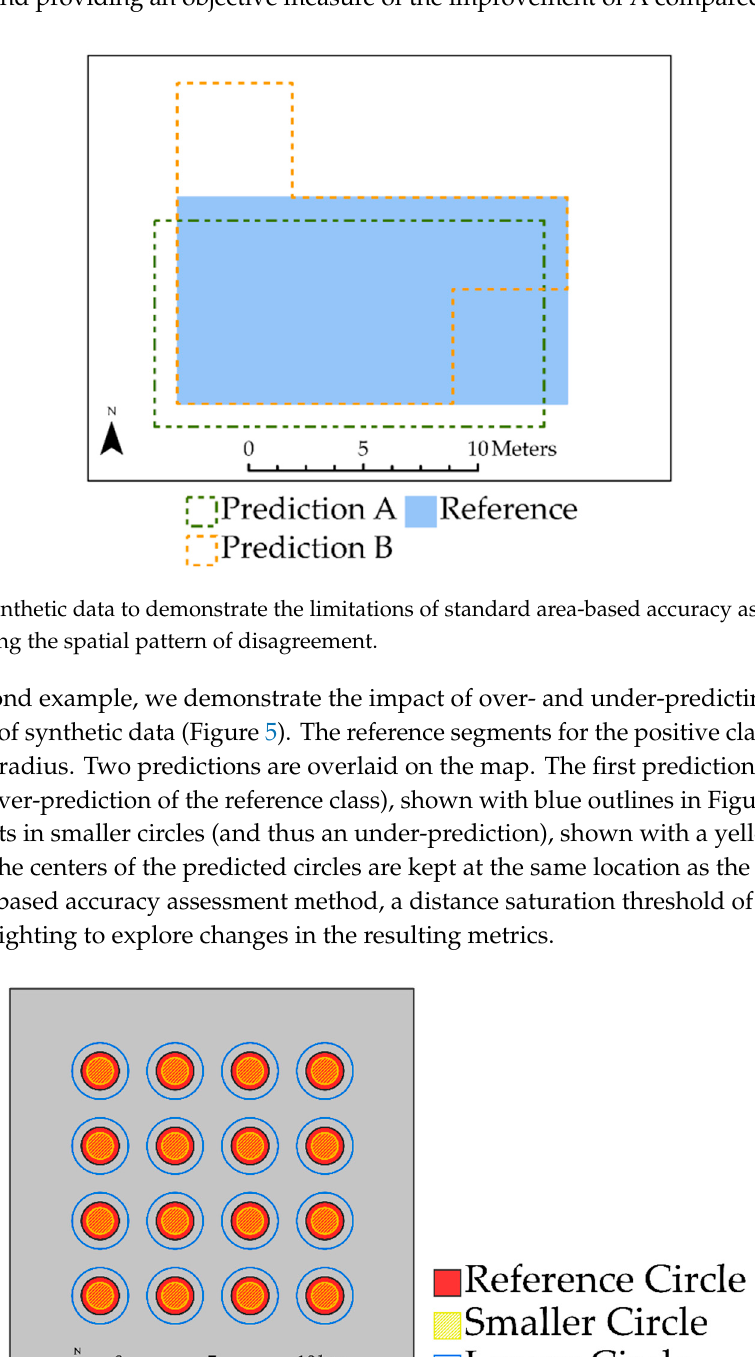
Table 3. Comparison of validation results for the synthetic features shown in Figure 4.